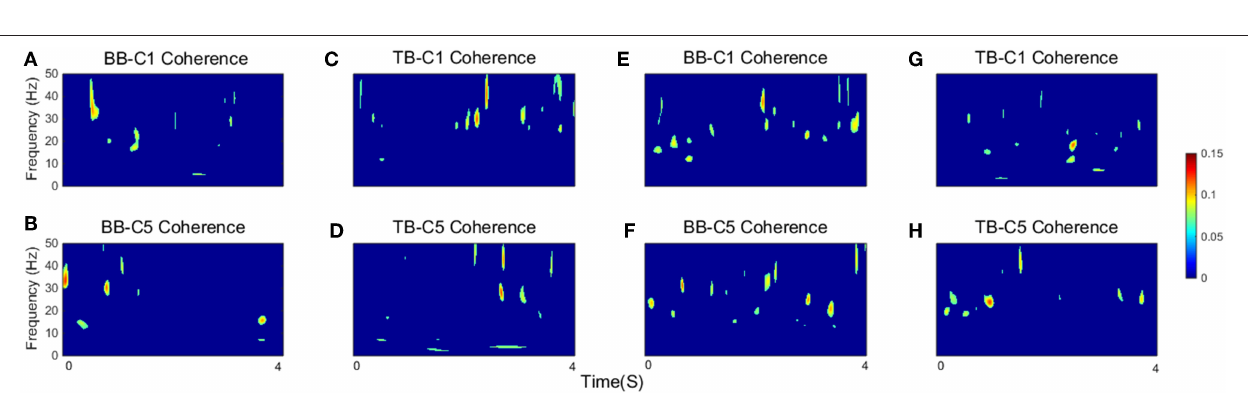
FIGURE 3 | . The volume of significant CMC between each EEG channel and BB and TB muscles in the beta- and gamma-range during isometric exercise (A,B) and isokinetic movement (C,D) . We denoted the volume of these 6 EEG channels is higher than other channels. Error bars show the standard error of the mean.